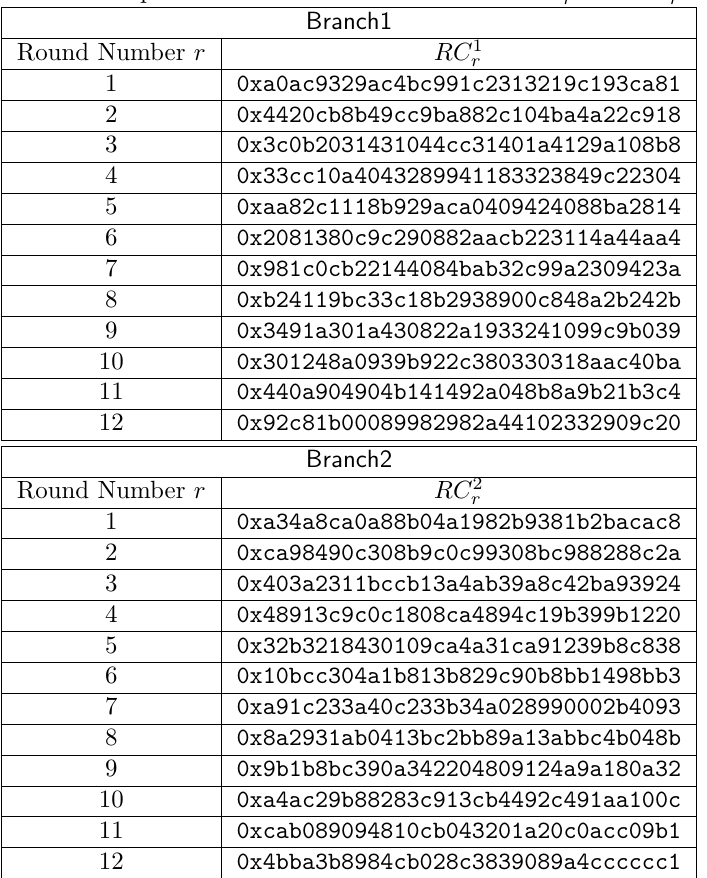
Table 10: Specification of the round constants RC 1